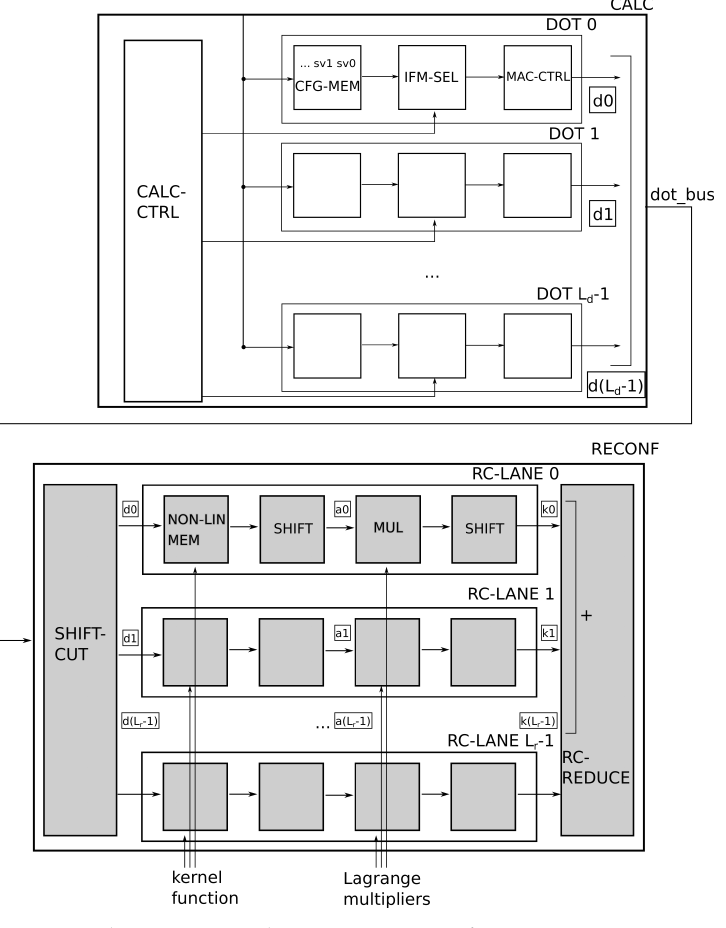
Figure 9. The RECONF architecture—SVM